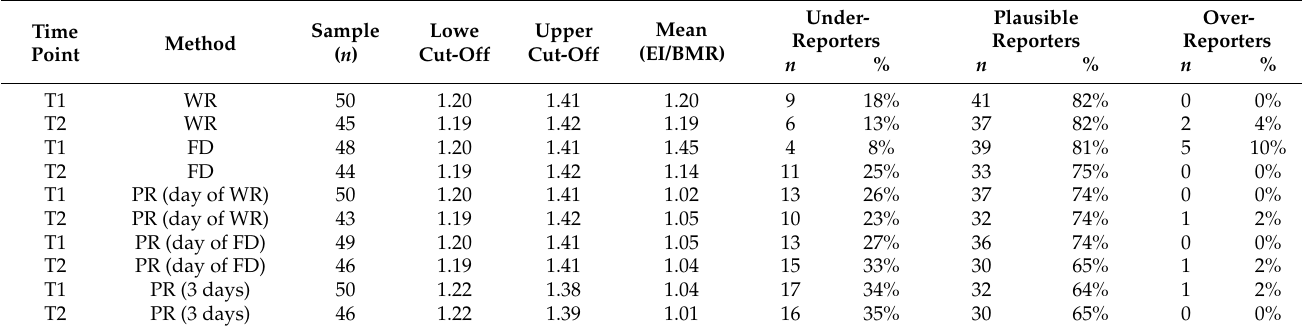
Table 4. Rates of plausible and implausible intakes for each assessment method.